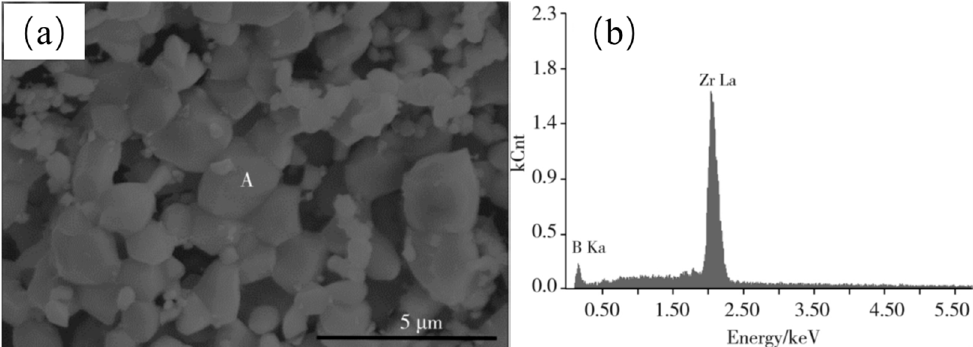
Figure 1. FESEM image of ZrB 2 powders ( a ) and EDS of point A ( b ) [60].